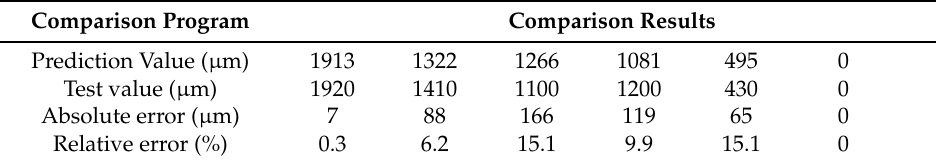
Table 4. Prediction results of splintering depth based on